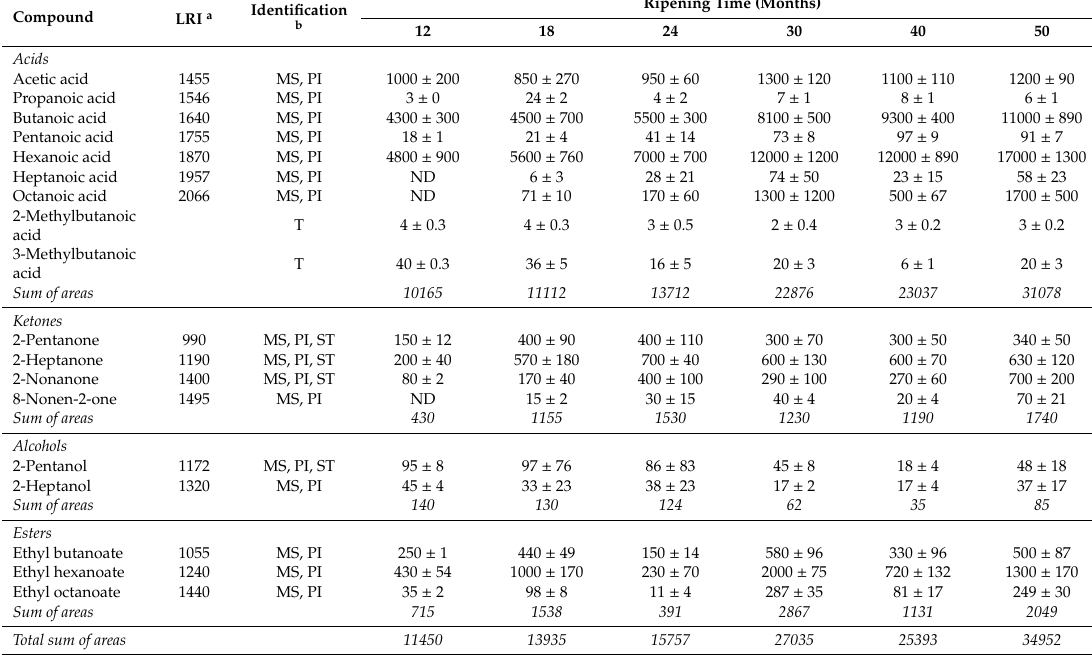
Table 3. Volatile compounds (area units / 10,000) identified in Parmigiano Reggiano cheeses ripened from 12 to 50